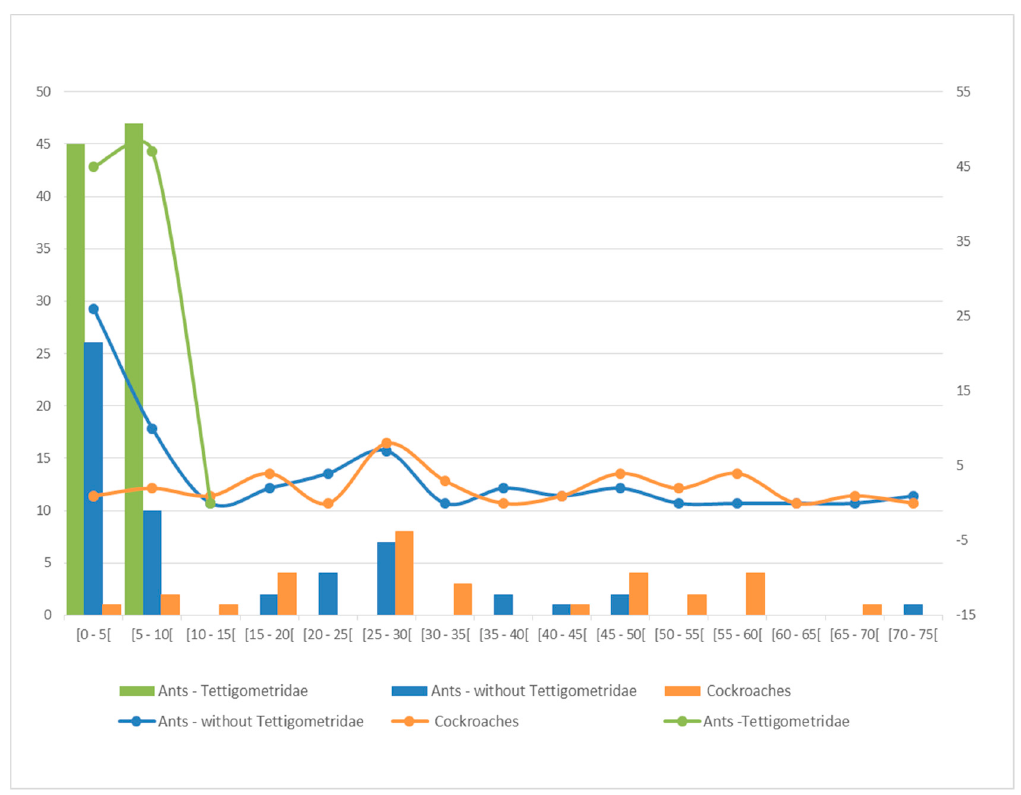
Figure 1. Number of trophobiosis observations according to average trophobiont size (in mm) being tended by ants for Tettigometridae alone (green), by ants for other planthoppers without tettigometrids (blue) or by cockroaches for all planthoppers (orange).